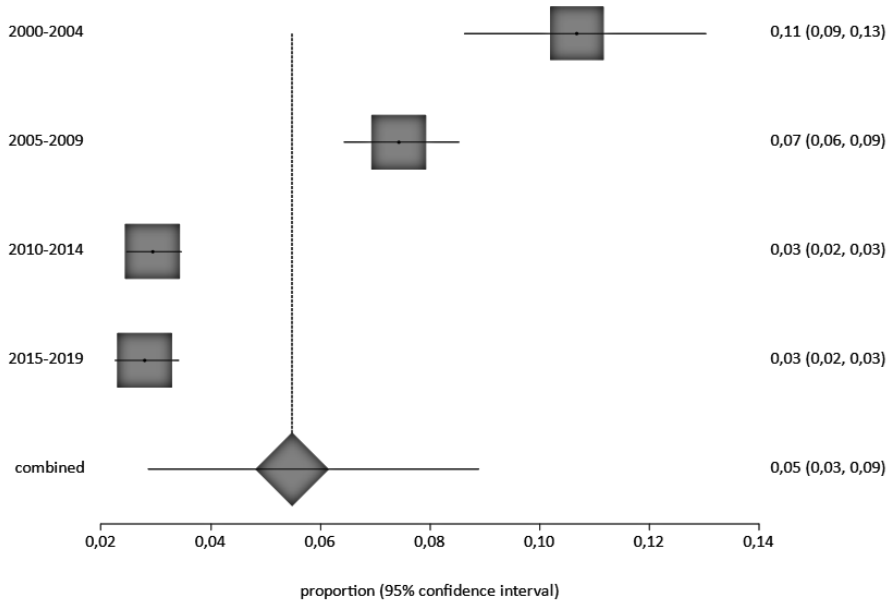
Figure 3. Forest Plot of Pooled HBV Prevalence by Year of Study Interval. A black square represents the HBV prevalence in the forest plot. The square position represents the prevalence.